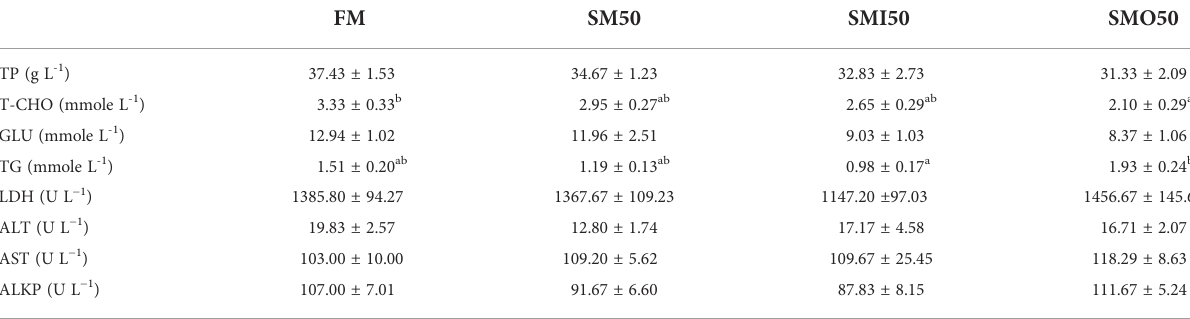
TABLE 5 Serum biochemical parameters of pikeperch fed the experimental diets for 8